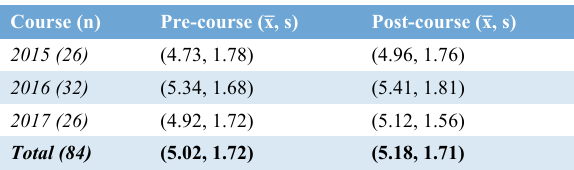
Tab. 2. Perceived feasibility: Year-by-year results for the